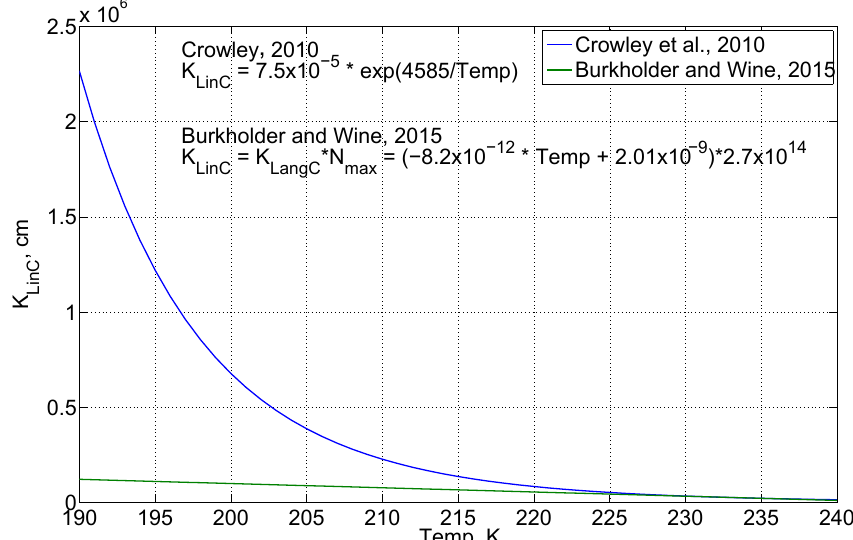
Figure B2. Langmuir adsorption equilibrium constant, K LinC = K eq × N max . The preferred temperature range for both parameterisations is 214–240K and within this range the two parameterisations provide a comparable value. The Crowley et al. (2010) parameterisation deviates from the Burkholder and Wine (2015) parameterisation as temperature drops below 214K due to the exponential temperature term. Here, the parameterisation from Burkholder and Wine (2015) was chosen based on the extreme cold temperature found in our validation sites (minimum winter temperature at Dome C is ∼ 199K, Erbland et al., 2013).